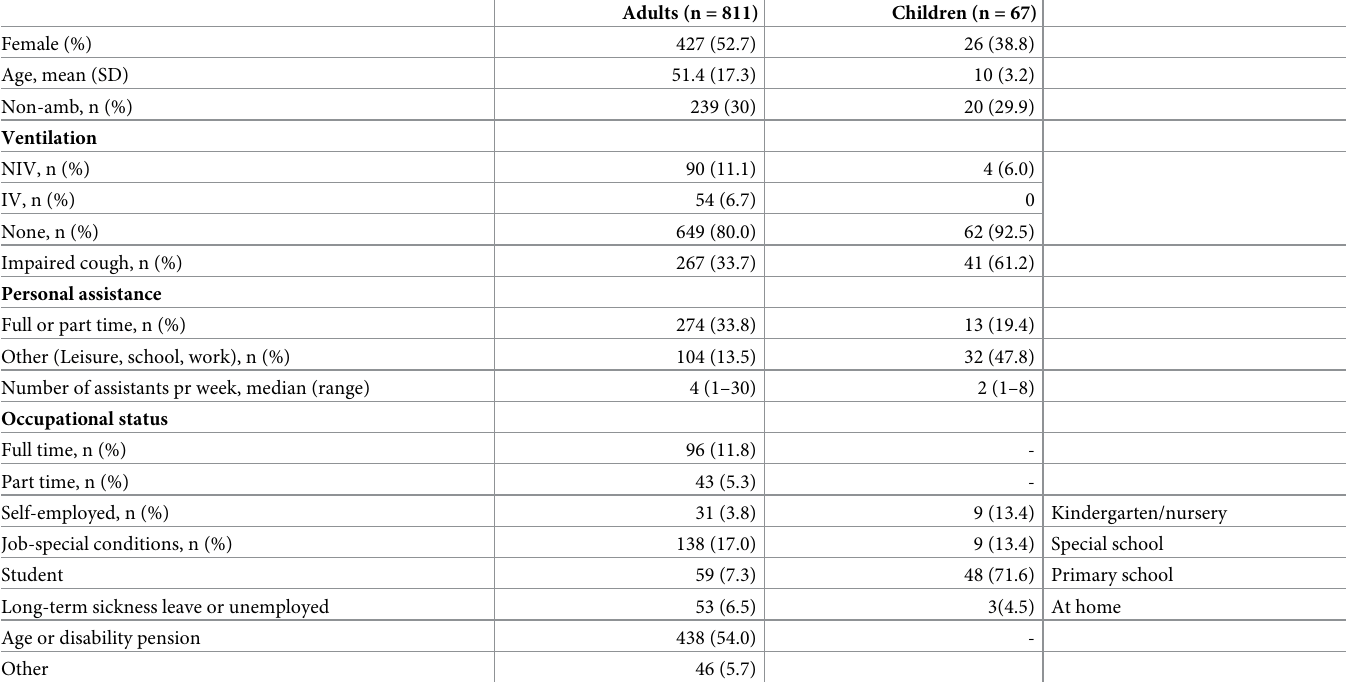
Table 1. Demographics and physical